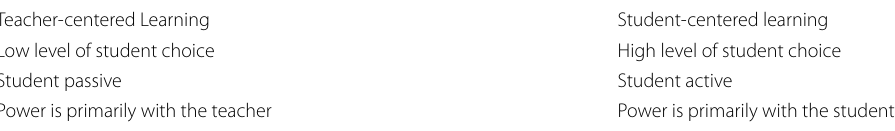
Table 2 Student-centered and teacher-centered learning assessment